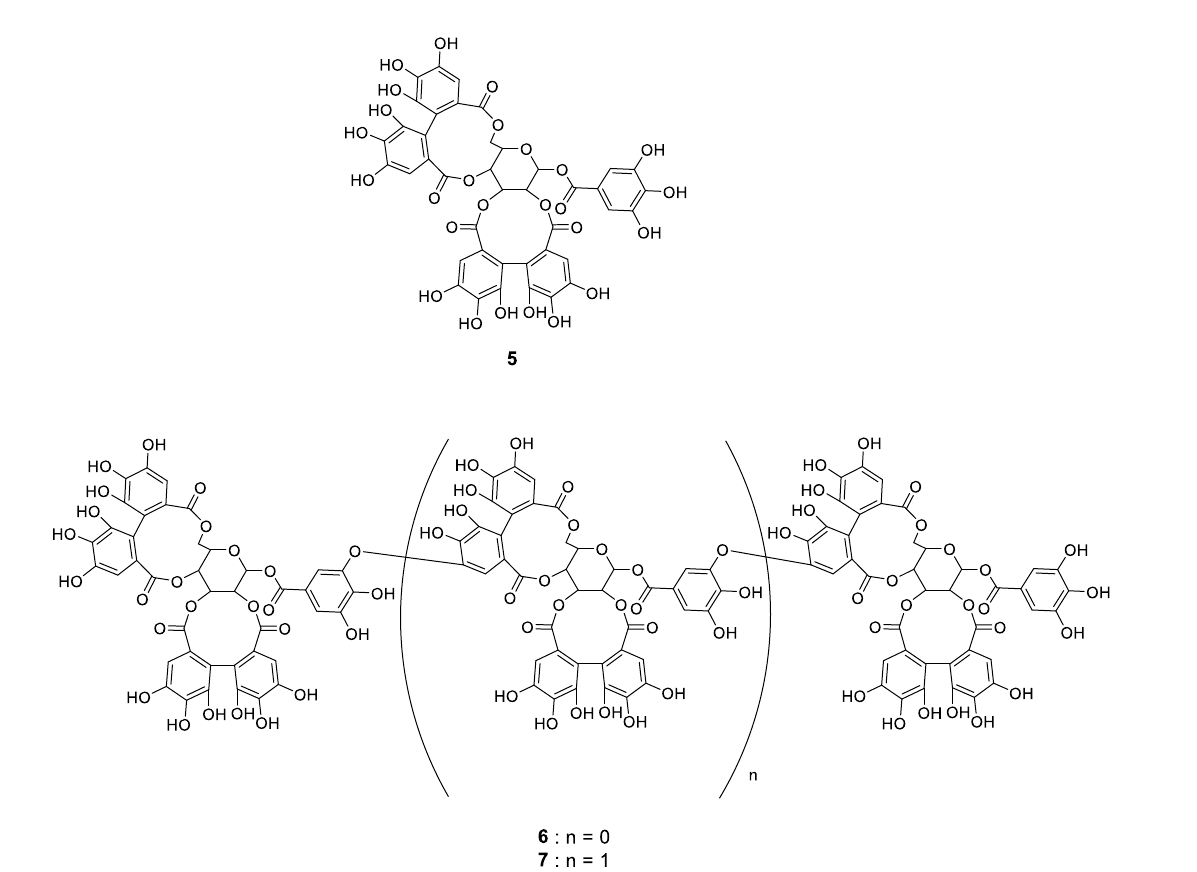
Figure 4. Structures of hydrolysable tannins contained in leaves of red raspberry.